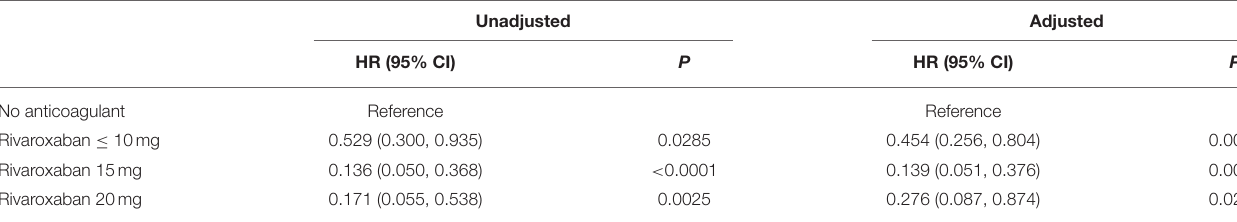
TABLE 3 | Univariate and multivariable analysis comparing the mortality of patients receiving rivaroxaban vs. no anticoagulant treatment. Unadjusted